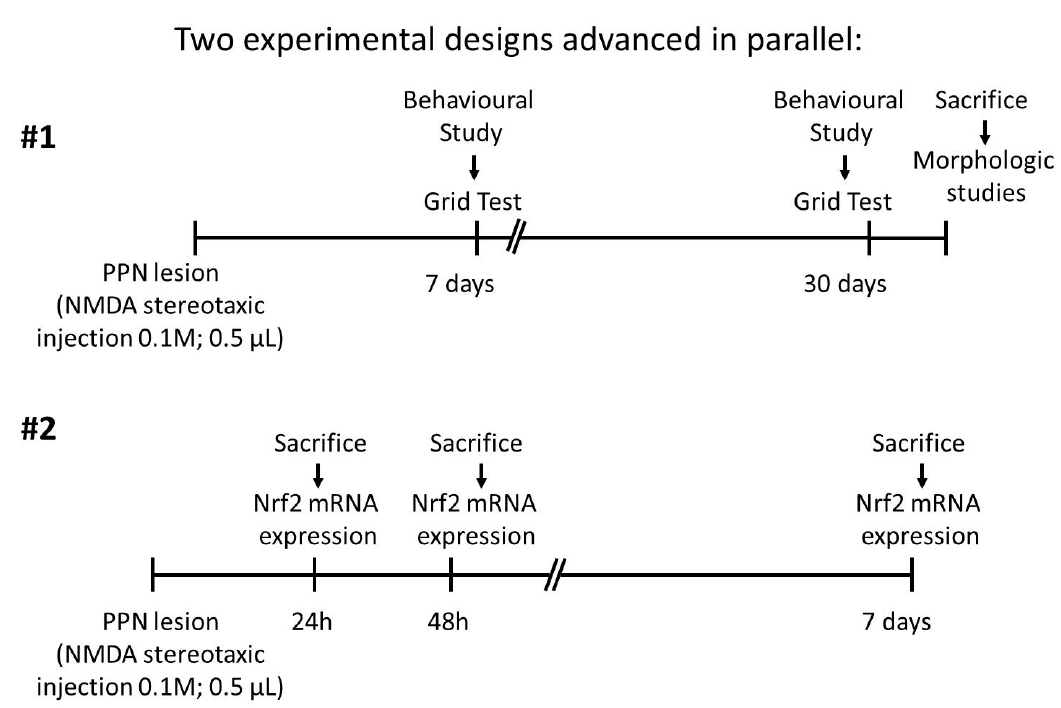
Figure 1. Two experimental designs progressed in parallel: #1. Behavioral study; #2. Molecular biology study. Unilateral neurotoxic lesion of right pedunculopontine nucleus was performed by injection of N-methyl-D-aspartate (NMDA) (Sigma, St. Louis, MO, USA) solution at a rate of 0.1 µ L / min using a 5 µ L Hamilton syringe. Experimental design #1: Motor coordination was studied by means of Grid test 7 and 30 days after pedunculopontine nucleus injury. When the behavioral studies concluded, the rats were sacrificed for morphological studies. Experimental design #2: Nigral Nrf2 mRNA expression was studied 24 h, 48 h and 7 days after PPN injury. The selection of lesioned / sham-operated rats to form the 48-h and 7-days post injury group was completely randomized.